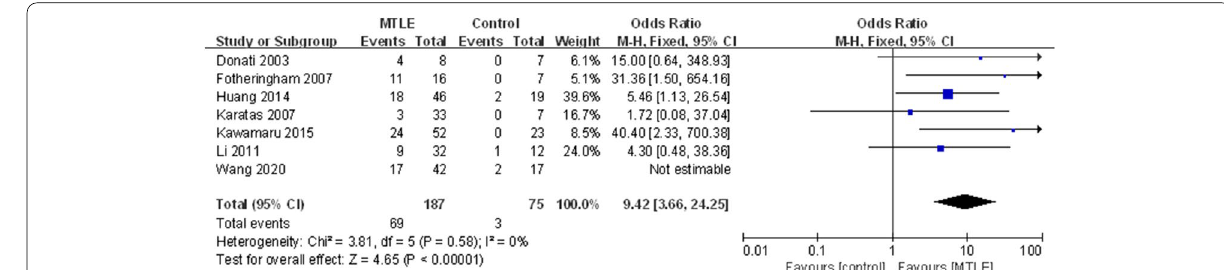
Fig. 2 Forest plots showing the relationship between HHV-6B and MTLE